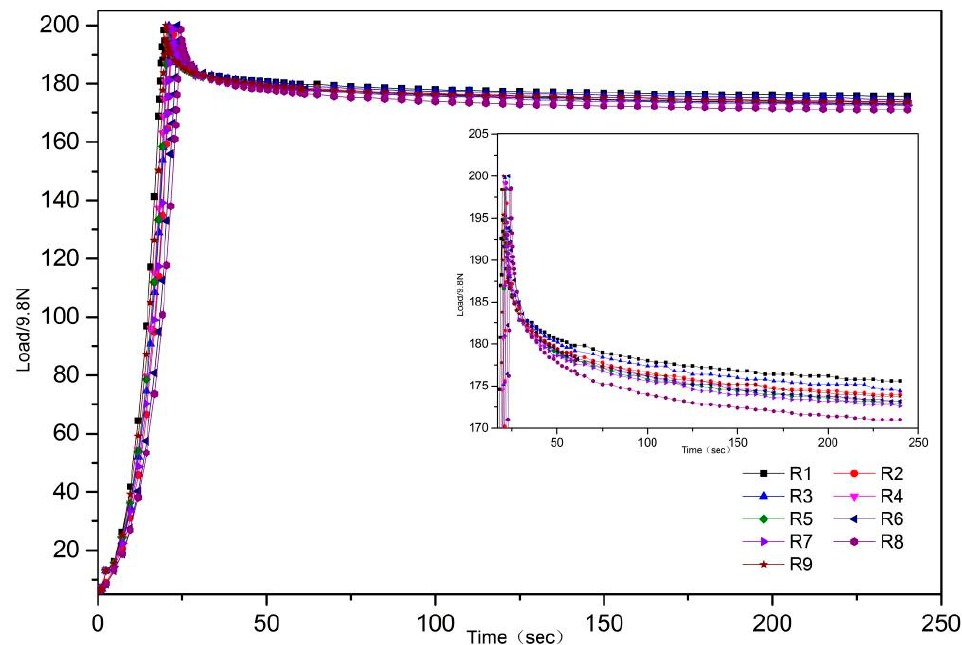
Figure 3. The stress-relaxation curves of R1–R9 .